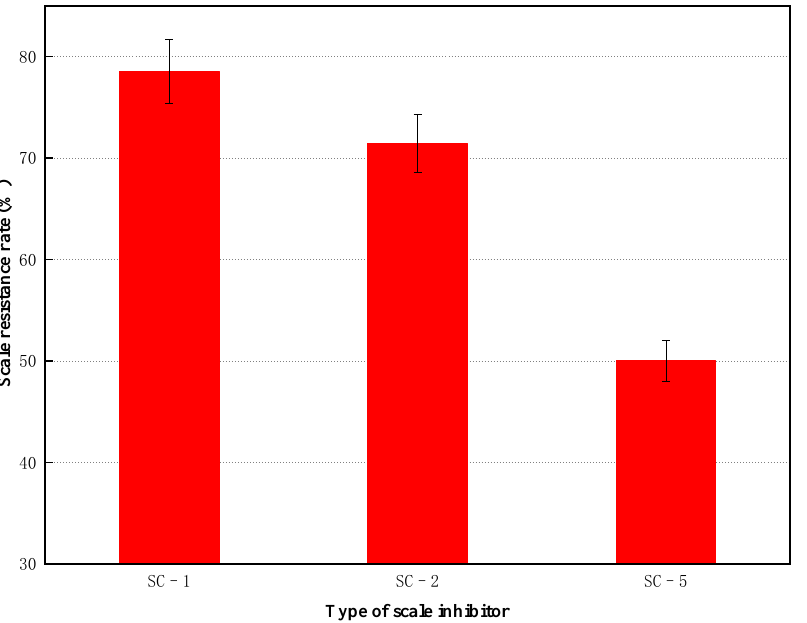
Figure 6. The mixed scale-inhibition ability of three optimal scale inhibitors at pH = 7 and room temperature.